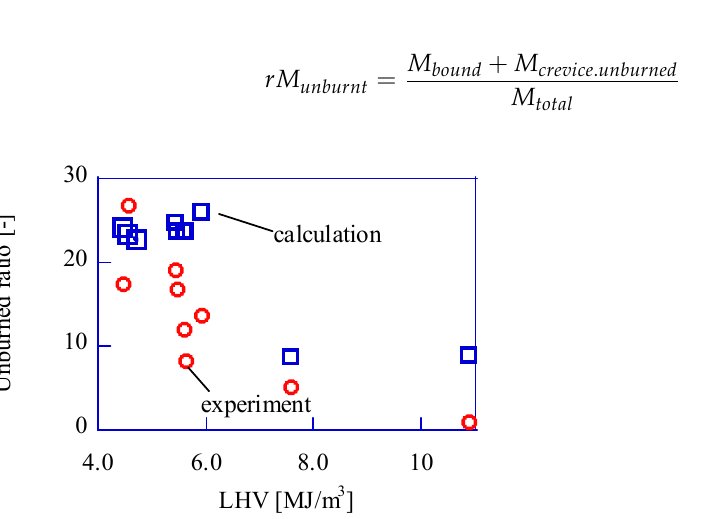
Figure 11. The unburned ratio is calculated by Equation (6). The calculated one shows almost the same as the experimental one.